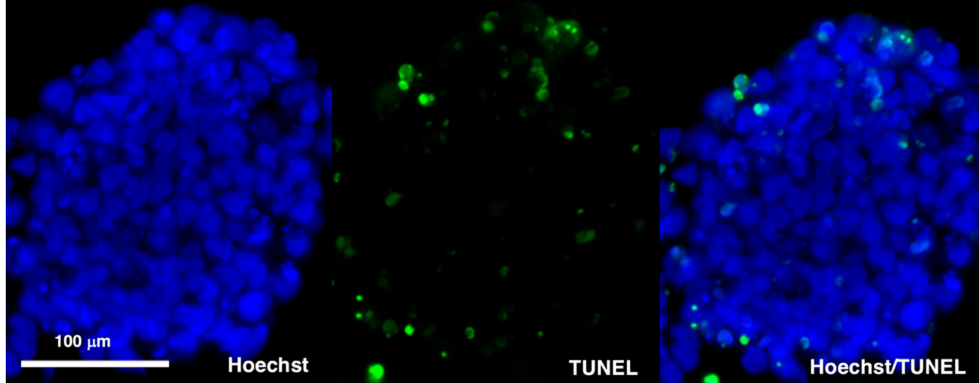
Figure 4. TUNEL assays. KhES-1 cells were subjected to the di ff erentiation according to the cytokine-free method and TUNEL assays were performed using Day 10 spheroids. Representative images of Hoechst 33342 stained nuclei and TUNEL positive signals in the section of the spheroid were